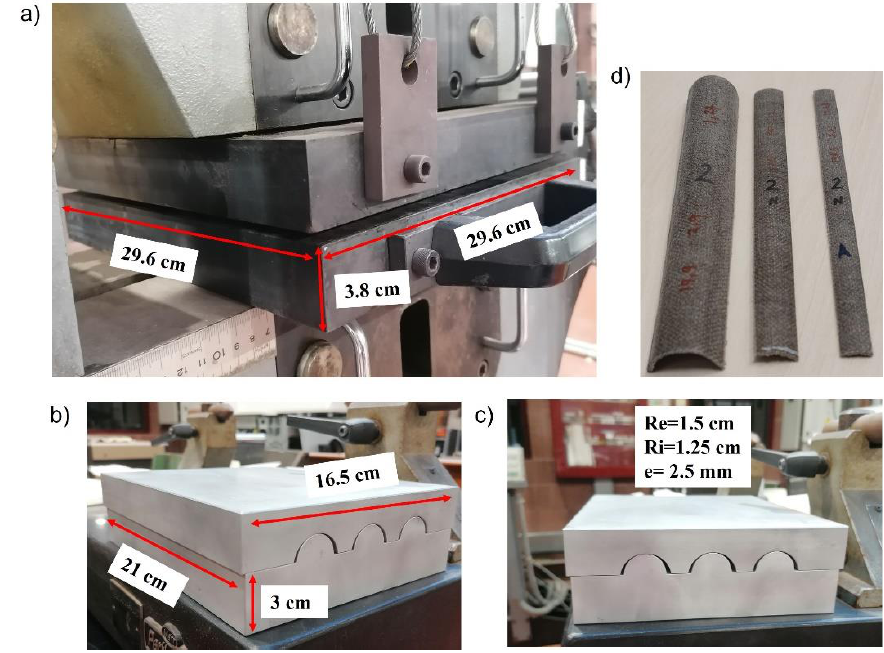
Figure 4. ( a ) Universal testing machine and heating plates, ( b , c ) Metallic molds for C-section columns, ( d ) manufactured specimens with three different cross-sections.